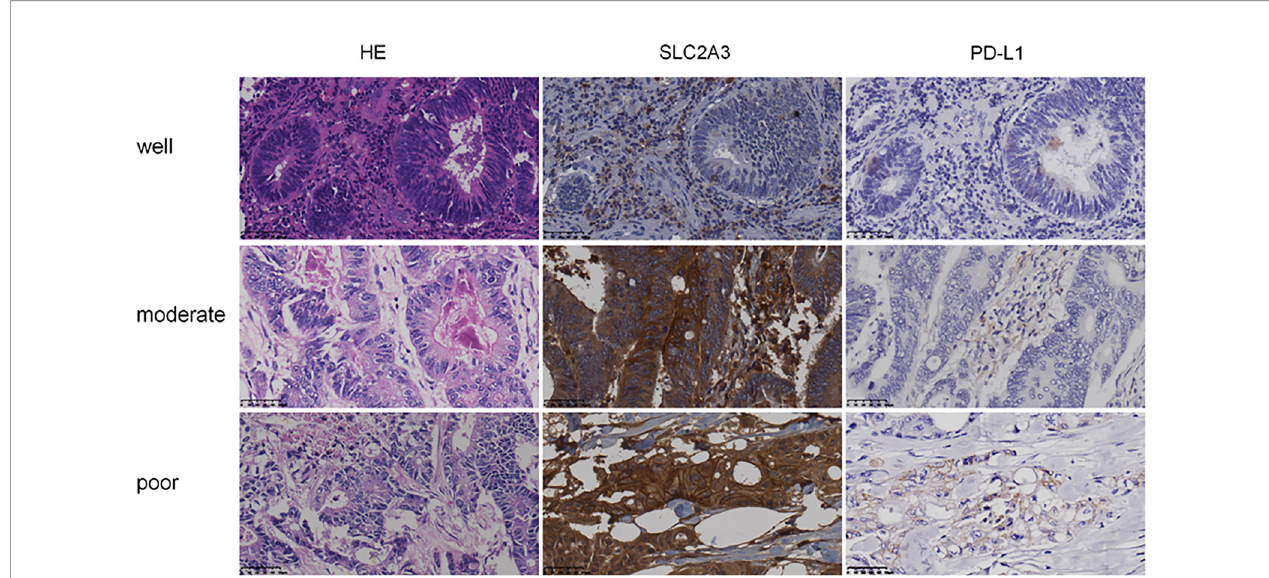
FIGURE 8 | Expression of SLC2A3 and PD-L1 in different differentiated CRC tissues (HE and IHC, original magni fi cation,